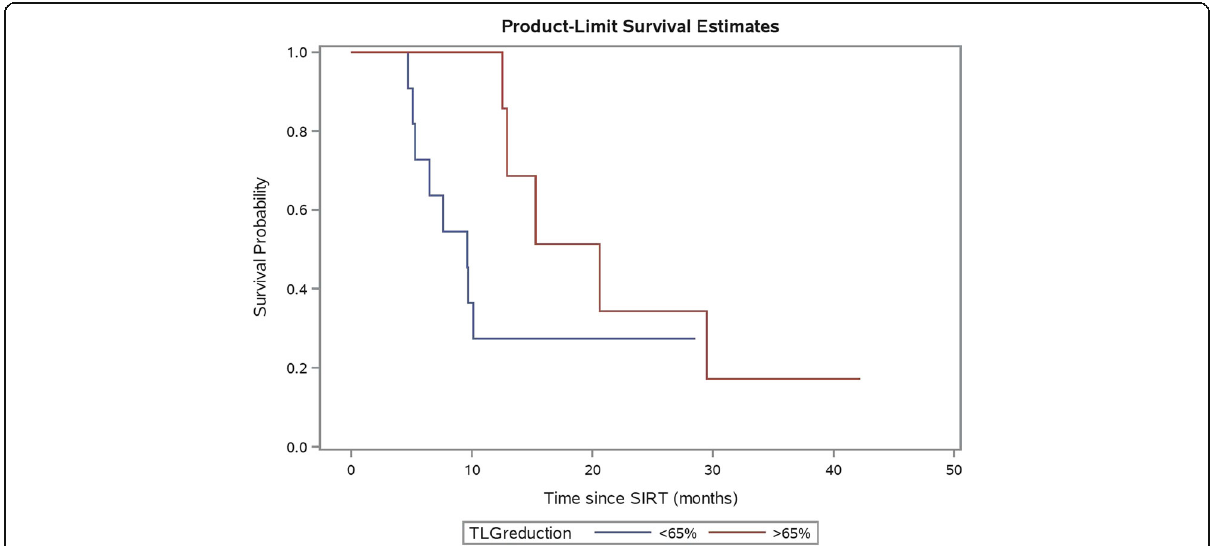
Fig. 9 Kaplan-Meier plot of patient survival by mean TLG reduction after radioembolisation analysed in categories of >65% vs. lower. Patients with TLG reduction >65% had improved overall survival compared to those with lower TLG reduction ( p = 0.028 by log-rank test)